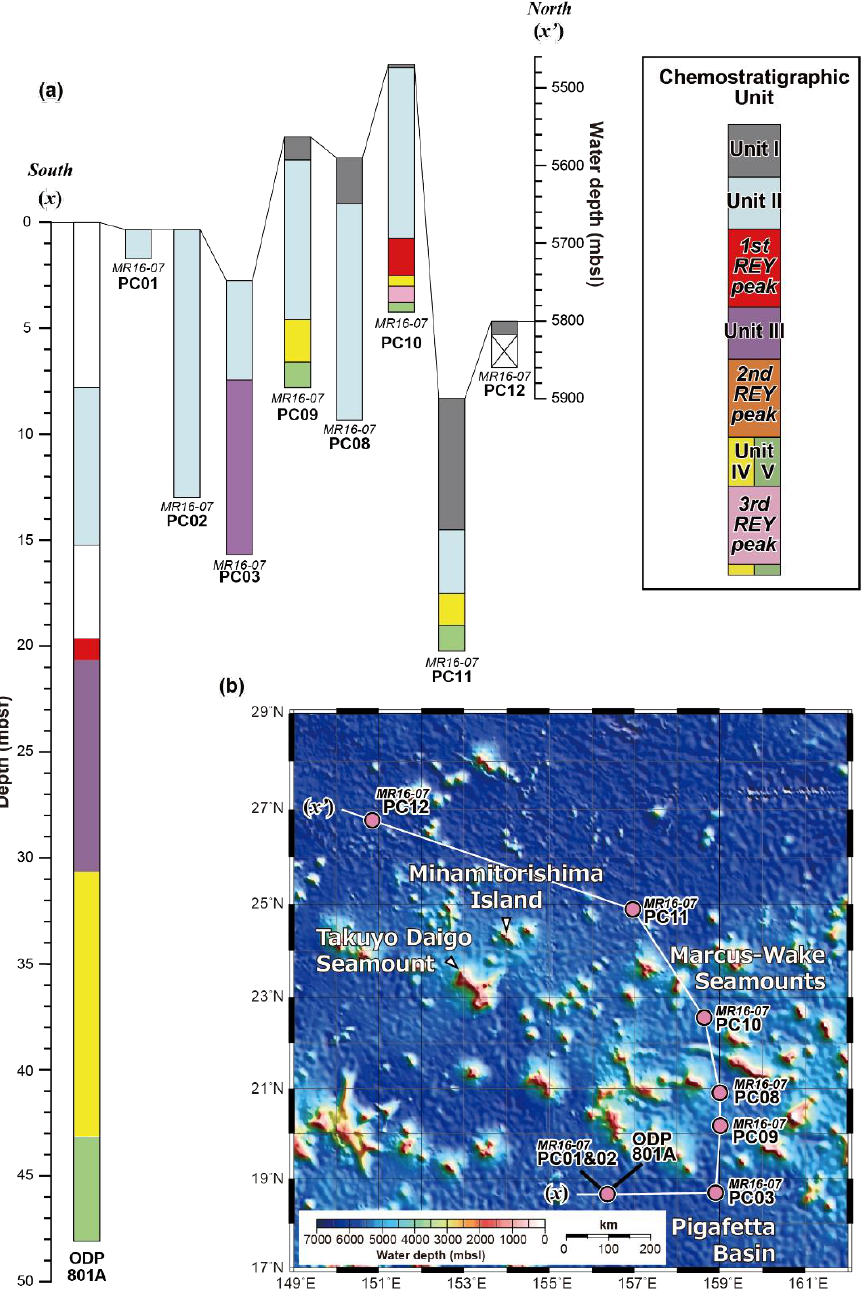
Figure 7. ( a ) Chemostratigraphic correlation in the area north of Minamitorishima Island, the northern Pigafetta Basin, and other small basins surrounded by the Marcus-Wake Seamounts (x–x′), and ( b ) broad map around Minamitorishima Island. The vertical positions correspond to their water depth (meters below sea level; mbsl) on the right scale. Their core lengths (meters below sea floor; mbsf) correspond to the left scale.